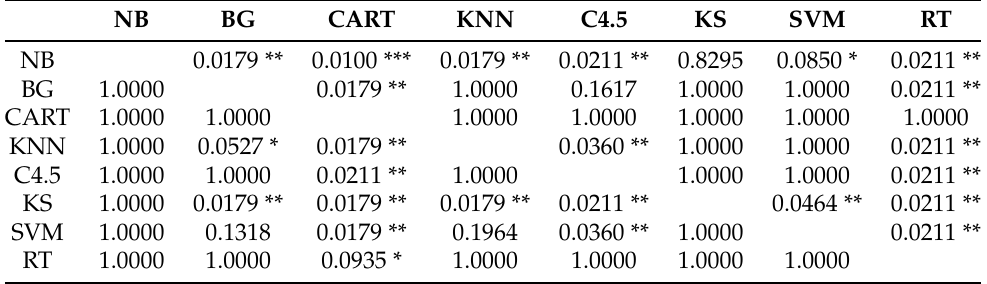
Table 16. Pairwise WSR Test for AUROC of Child.